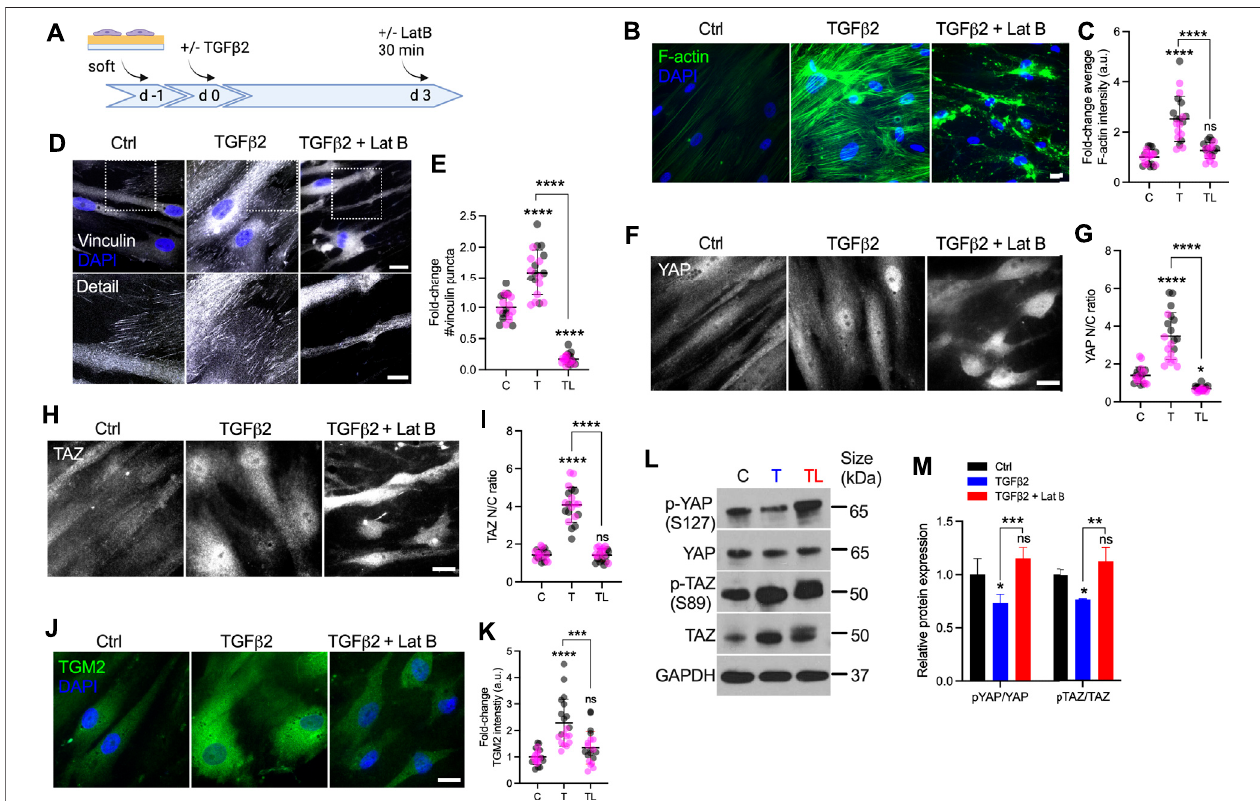
FIGURE4| LatBreducesYAP/TAZactivityinHTMcells. (A) SchematicshowingtimecourseofLatBexperimentswithHTMcells. (B) Representative fl uorescence micrographs ofF-actinin HTM cells on soft hydrogels subjected tocontrol, TGF β 2(2.5 ng/ml),TGF β 2 +Lat B (2 µM) at 3 days (F-actin = green; DAPI = blue). Scale bar, 20 μ m. (C) Quanti fi cation of F-actin intensity ( n = 20 images from 2 HTM cell strains with three replicates per cell strain). (D) Representative fl uorescence micrographs of vinculin in HTM cells on soft hydrogels subjected to the different treatments (dashed box shows region of interest in higher magni fi cation image; vinculin = grey; DAPI = blue). Scale bar, 20 and 10 μ m. (E) Analysis of number of vinculin puncta ( n = 20 images from 2 HTM cell strains with three replicates per cell strain). (F,H) Representative fl uorescence micrographs of YAP/TAZ in HTM cells on soft hydrogels subjected to the different treatments (YAP/TAZ = grey). Scale bar, 20 μ m. (G,I) AnalysisofYAP/TAZnuclear/cytoplasmicratio( n =20imagesfrom2HTMcellstrainswiththreereplicatespercellstrain). (J) Representative fl uorescencemicrographsof TGM2 in HTM cells on soft hydrogels subjected the different treatments (TGM2 = green; DAPI = blue). Scale bar, 20 μ m. (K) Analysis of TGM2 intensity ( n = 20 images per group from 2 HTM cell strains with three replicates per HTM cell strain). (L,M) Immunoblot of p-YAP, total YAP, p-TAZ and total TAZ, and immunoblot analysis of p-YAP/YAP and pTAZ/TAZ ( n = 3 replicates). Symbols with different colors represent different cell strains. The lines or bars and error bars indicate Mean ± SD. Signi fi cance was determined by one-way (C,E,H,J,L) and two-way ANOVA (F) using multiple comparisons tests (* p < 0.05; ** p < 0.01; *** p < 0.001; **** p < 0.0001).